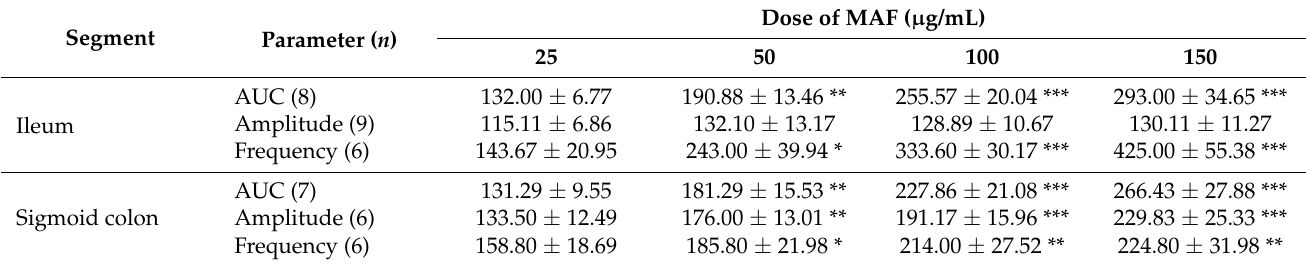
Table 1. Relative values of AUC, amplitude, and frequency (% of control) for spontaneous contractions after treatment with each dose of MAF in human ileal and colonic smooth muscle strips in situ.